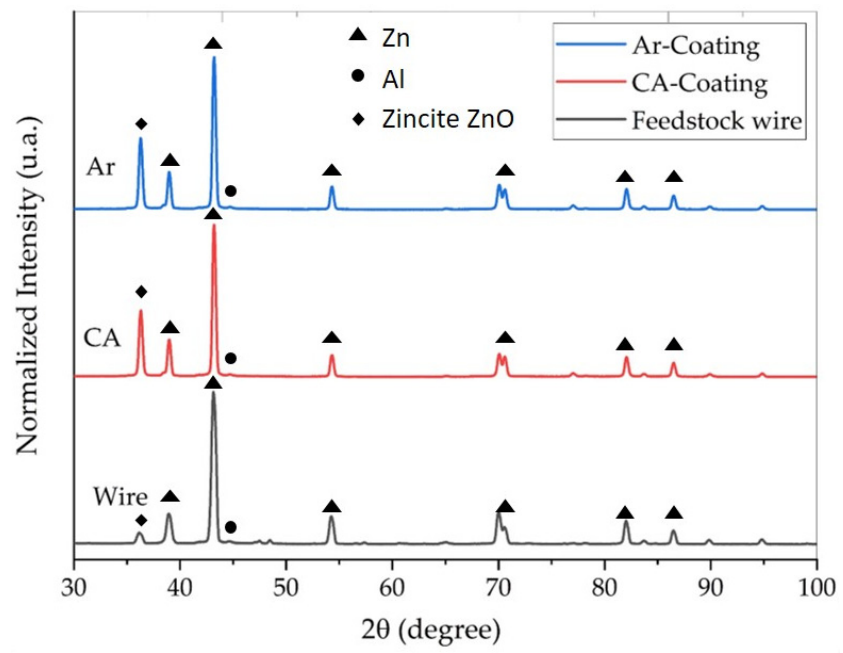
Figure 2. X-ray diffraction pattern of ZnAl4, as wires, sprayed coating using compressed air (CA), and argon (Ar).